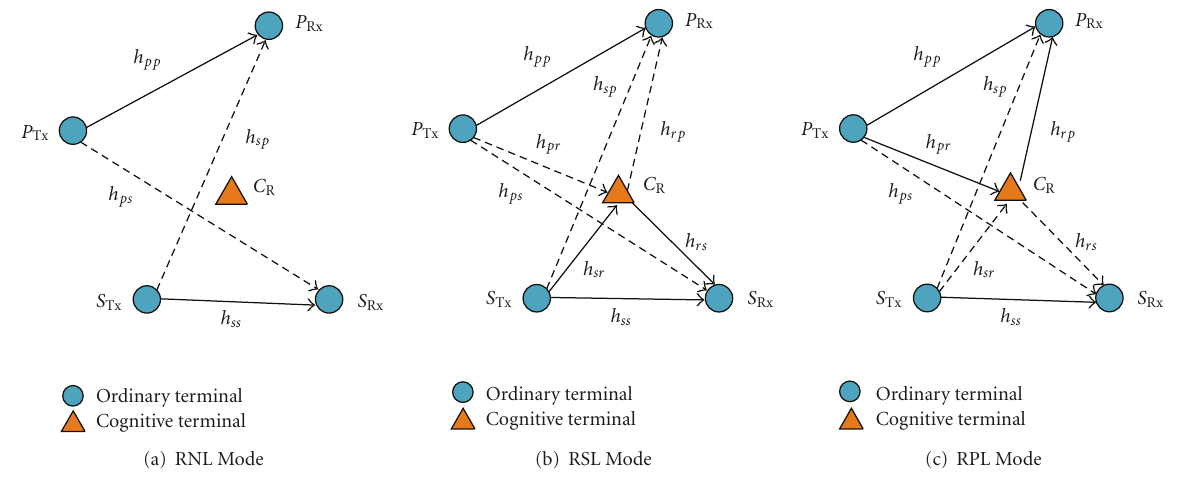
Figure 2: The three modes in OCR